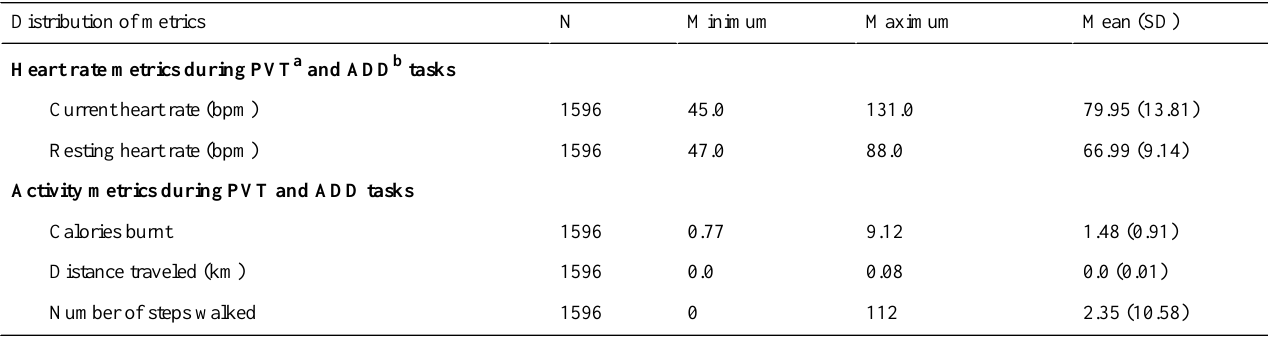
Table 3. Distribution of heart rate and activity metrics obtained from the Fitbit during completion of the cognitive